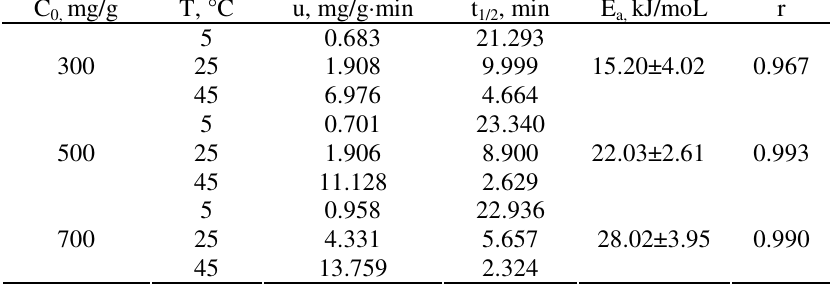
Table 10. Kinetic parameters for the second order adsorption model of PEG (20000) C 0,